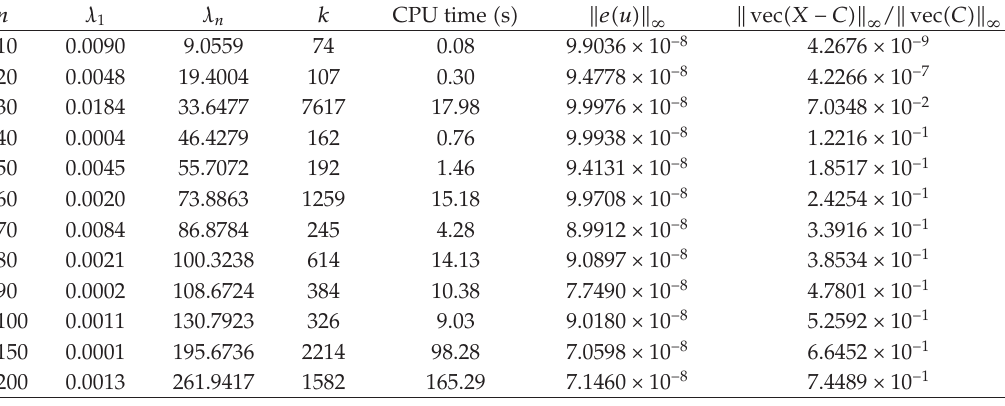
Table 2: Numerical results of example